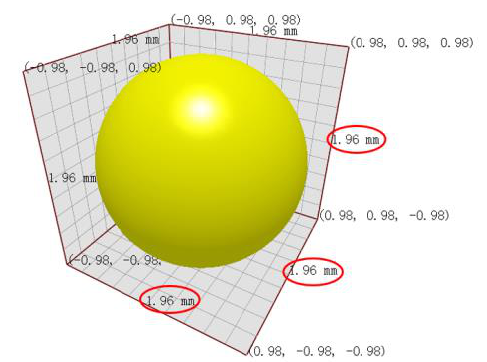
Figure 3. Model of a rapeseed particle.